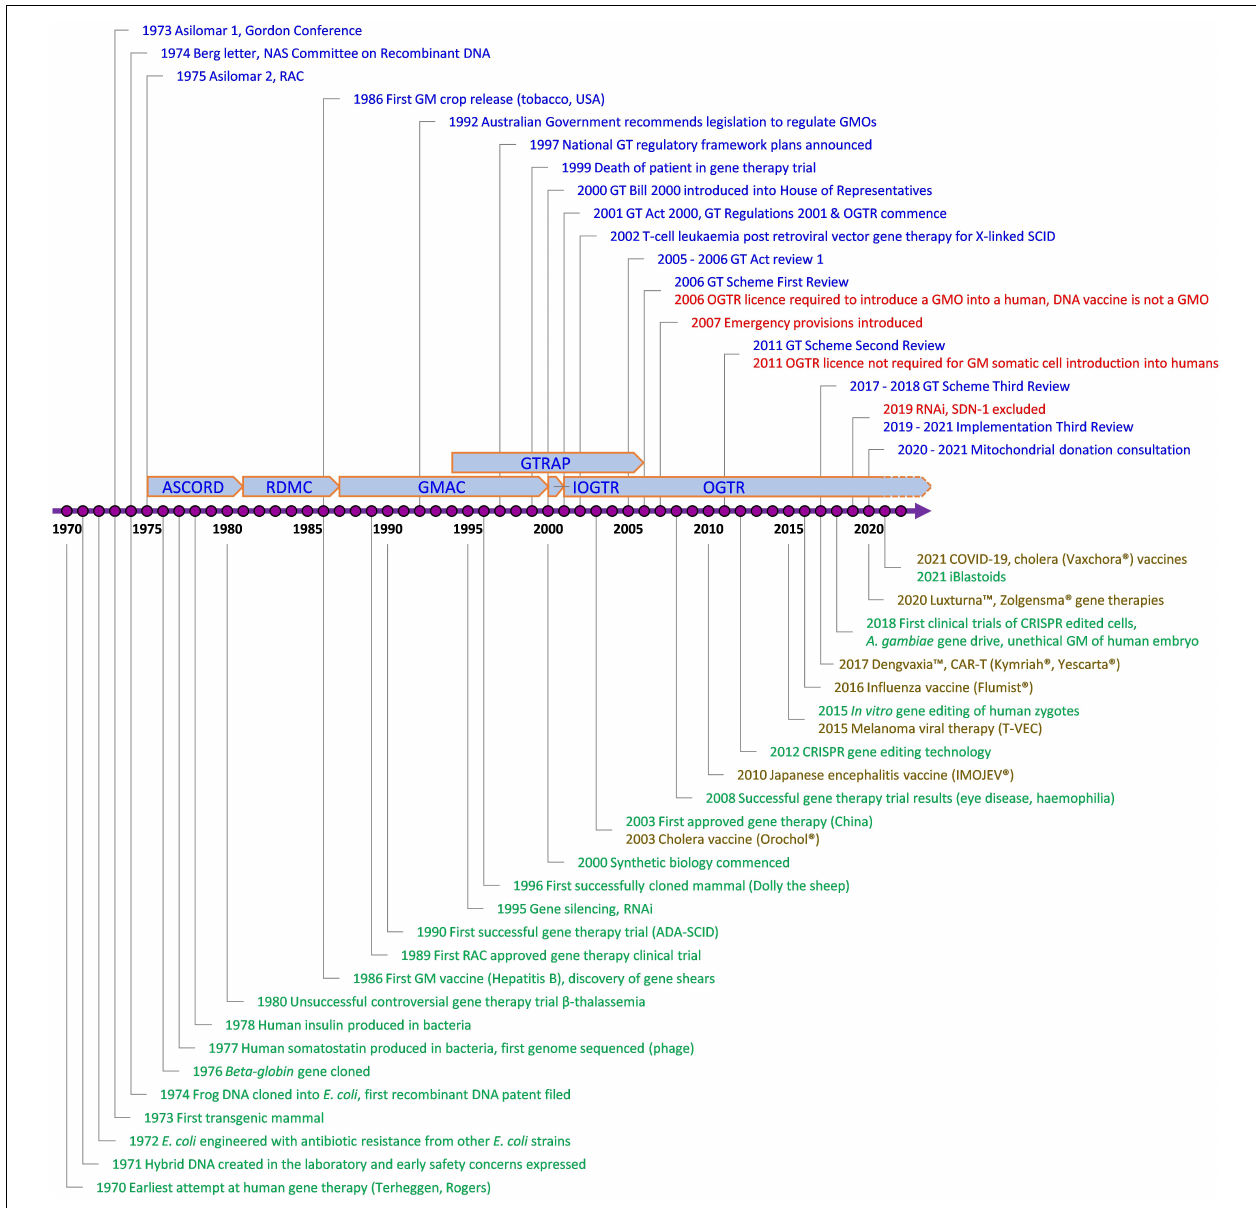
FIGURE 2 | Key events involving gene technology and its regulation in Australia of relevance to human therapeutics. Blue, Contains key regulatory events; Green, Examples of key scientific or technological events; Red, Key changes to regulatory requirements as a result of amendments to the Australian Gene Technology legislation; Brown, Commercially approved gene based therapeutic products in Australia; ADA-SCID, Severe Combined Immuno-Deficiency caused by defective Adenosine deaminase gene; ASCORD, Australian Academy of Science Committee On Recombinant DNA; COVID-19, Coronavirus Disease 2019 caused by Severe Acute Respiratory Syndrome Coronavirus 2 (SARS-CoV-2); CRISPR, Clustered Regularly Interspaced Short Palindromic Repeats; DNA, Deoxyribonucleic acid; GM, Genetically Modified; GMAC, Genetic Manipulation Advisory Committee; GMO, Genetically Modified Organism; GT, Gene Technology; GTRAP, Gene and Related Therapies Advisory Panel; IOGTR, Interim Office of the Gene Technology Regulator; OGTR, Office of the Gene Technology Regulator; RAC, Recombinant DNA Advisory Committee, United States; RDMC, Recombinant DNA Monitoring Committee; RNAi, interfering RNA as technology; SCID, Severe Combined Immuno-Deficiency; SDN-1, Site-Directed Nuclease which does not involve the use of a guide nucleic acid. The earliest attempt at human gene therapy was an unsuccessful trial of wild-type Shope papilloma virus administered to three hyperargininemic subjects [Terheggen et al.